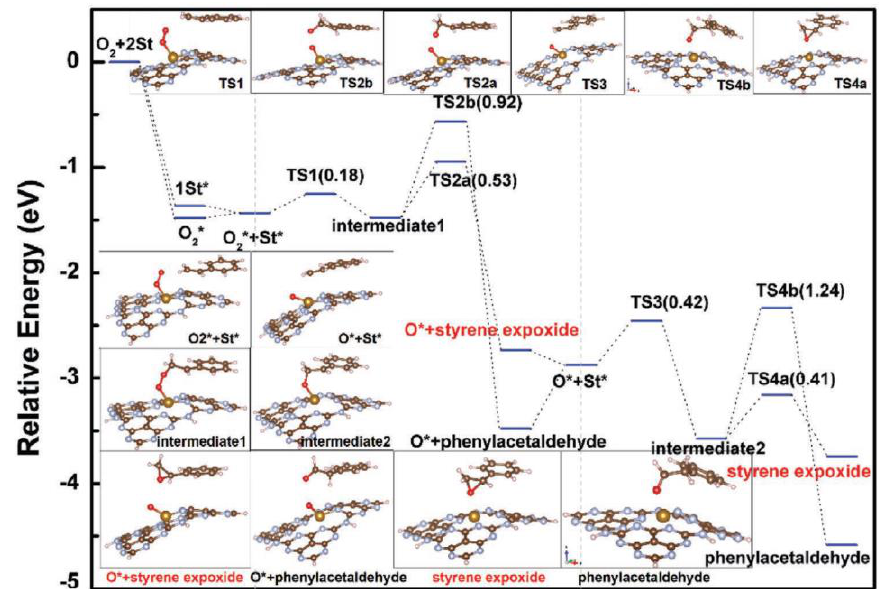
Figure 7. ( a ) Epoxidation of olefines with Fe-N/C catalyst. Reprinted with permission from Ref. [73]. Copyright 2019, Elsevier. ( b ) Schematic diagram for the preparation of SAS-Fe.